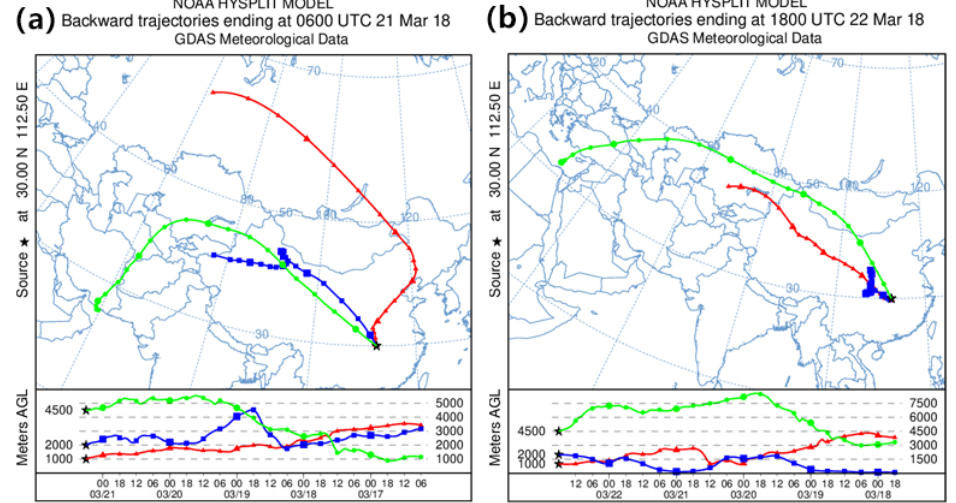
Figure 12. Five-day backward trajectories arrived in the Jianghan Plain at altitudes of 1.0, 2.0, and 4.5 km (in red, blue, and green) at 06:00 UTC on 21 March 2018 ( a ) and 18:00 UTC on 22 March 2018 ( b ). Tracing altitudes are determined by the altitudes of dust layers from CALIOP level-2 vertical feature mask products. Calculations are performed with the HYSPLIT model [61].